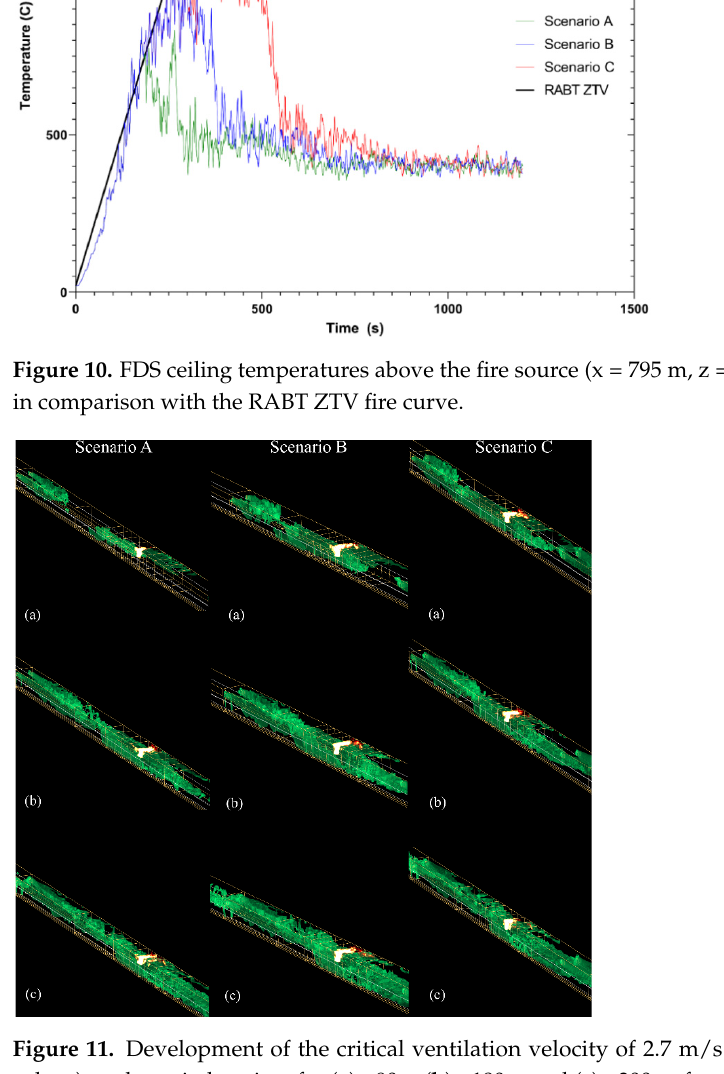
Figure 12. Lengthwise U velocity at symmetry plane y = 5.5 m and z = 3.5 m for Scenario A at dif- ferent time frames (t = +180 s, +270 s, +600 s, and +720 s).